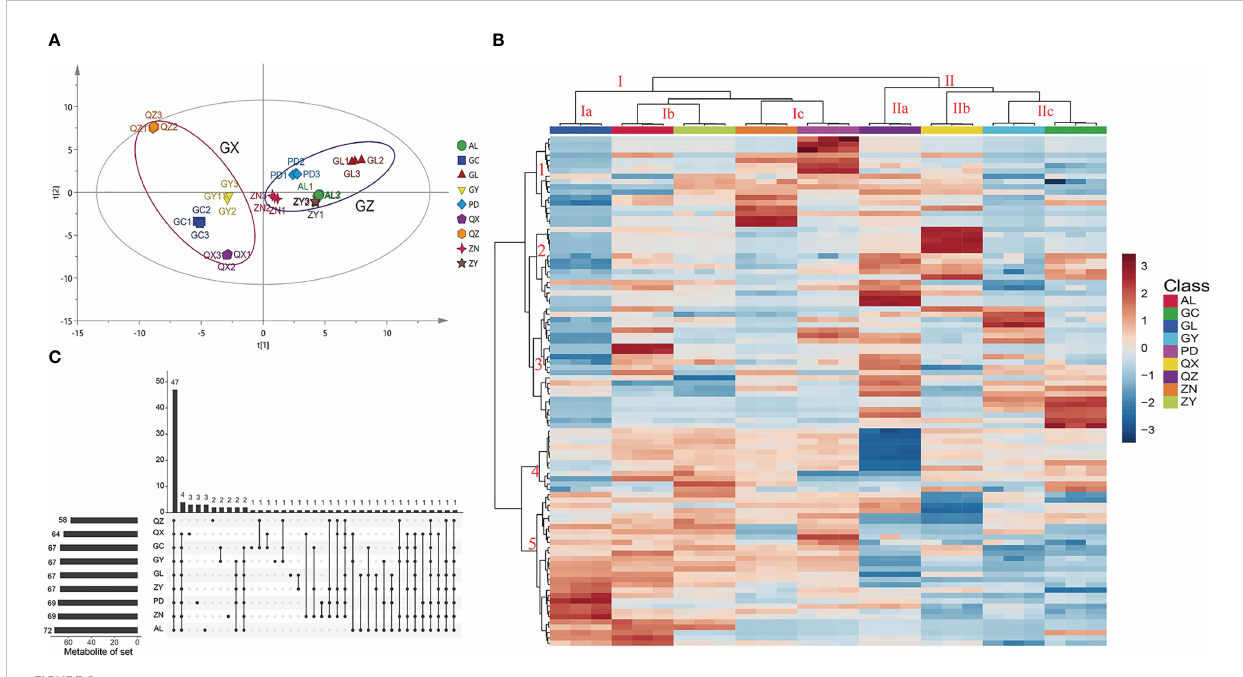
FIGURE 2 Multivariate statistical analysis of P. petiolosa from different geographic origins based on UPLC-MS pro fi les. (A) Score plot of principal component analysis. (B) Heatmap of 97 fl avonoid components in P. petiolosa samples from different geographic origins; the heatmap colours indicate the concentration of each metabolite, from low (blue) to high (red). (C) The UpSet diagram shows the overlapping and origin-speci fi c fl avonoid components in P. petiolosa